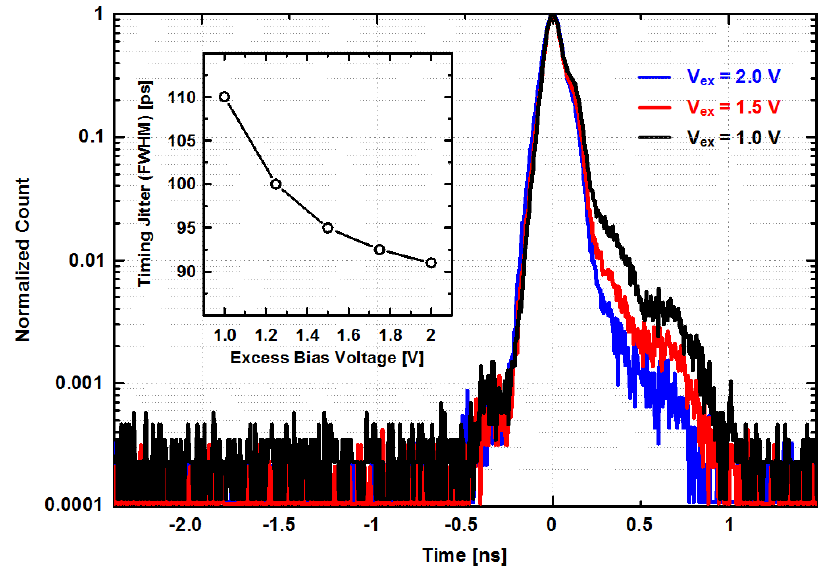
Figure 7. Time response of SPAD. Inset shows the dependency of V ex on the timing jitter (full-width at half-maximum (FWHM)).